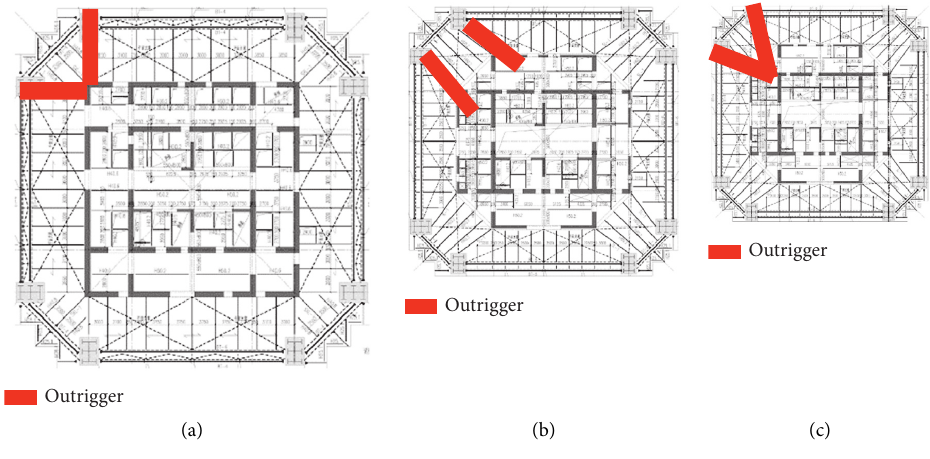
Figure 18: Lateral load-resisting system. Table 5: Belt truss and outrigger floor in the prototype.